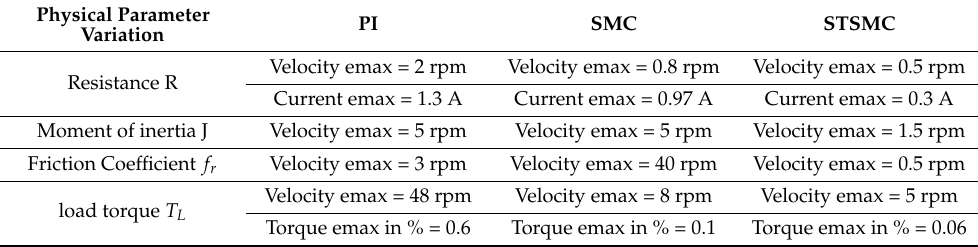
Table 2. Evaluation of the robustness of the three